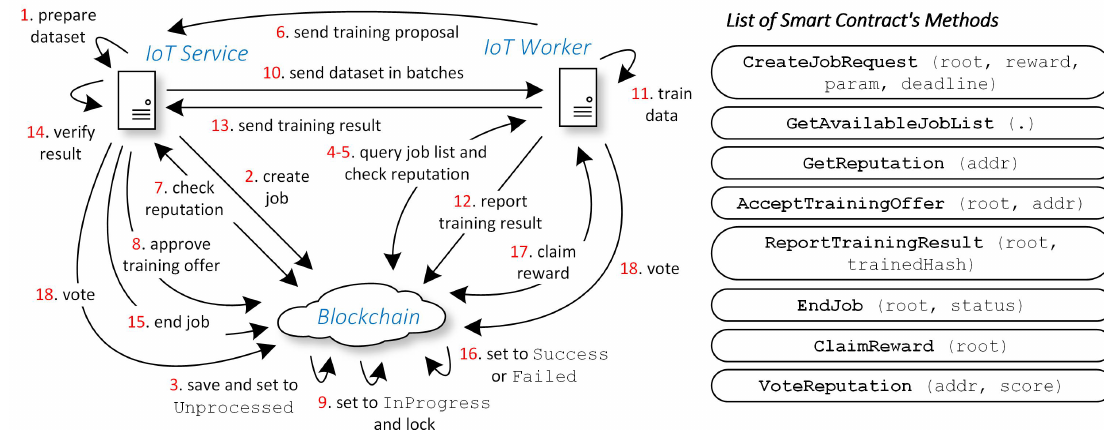
Figure 7. Overview of our blockchain design of the decentralized marketplace: the design flow starts from an IoT service creating a training job offer for IoT workers. The workers then propose a training offer. If negotiation is complete, the worker trains IoT service’s data and submits reports back to the service and blockchain. Finally, the worker claims their reward when the job finishes. The figure also depicts a list of smart contract methods for developers to